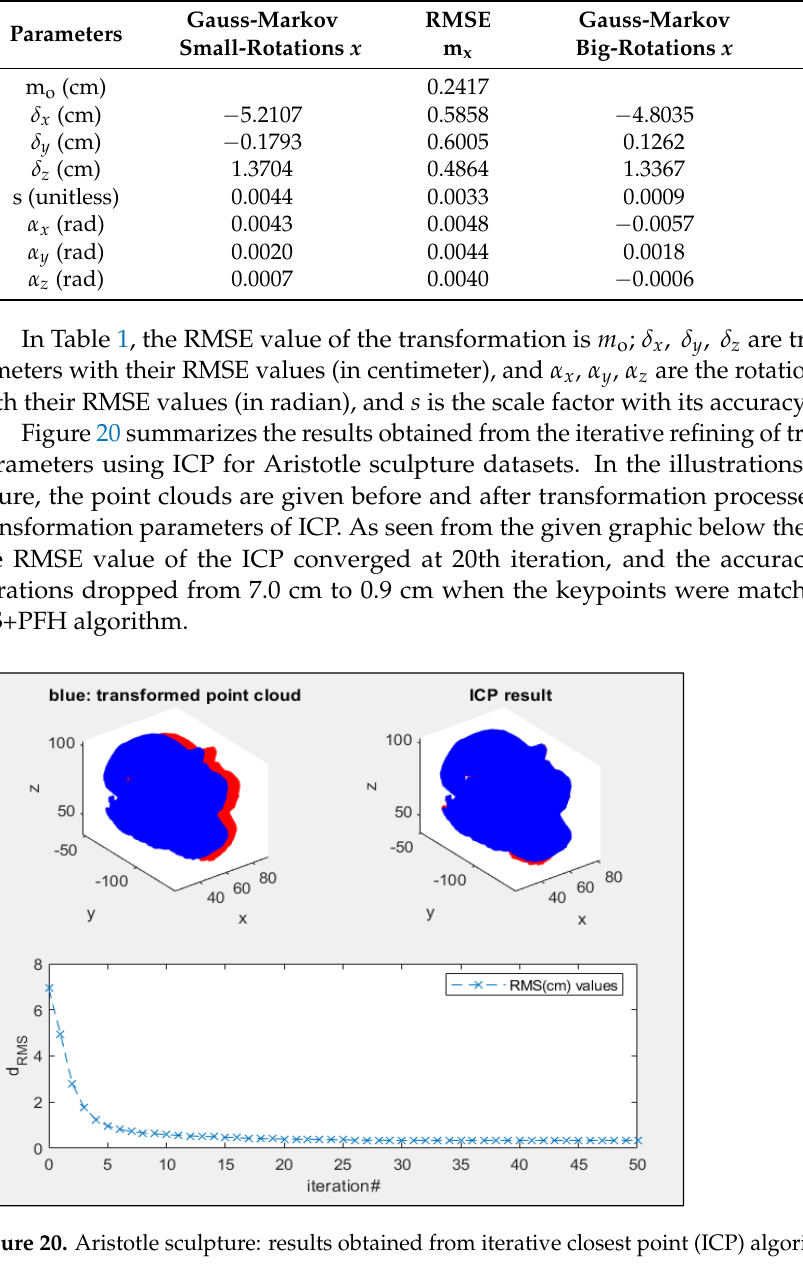
Table 2. Aristotle sculpture: transformation parameters ( (cid:2206) ) with their RMSE ( m x ) in coarse regis- tration with the LSP+PFH method.